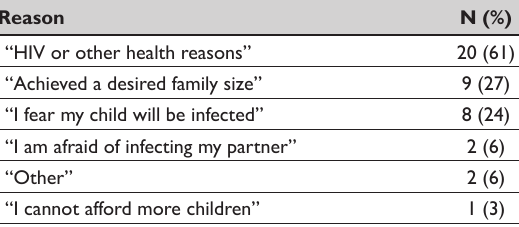
Table 3: Reason for ceasing childbearing among women not desiring (more) children (N=33)*